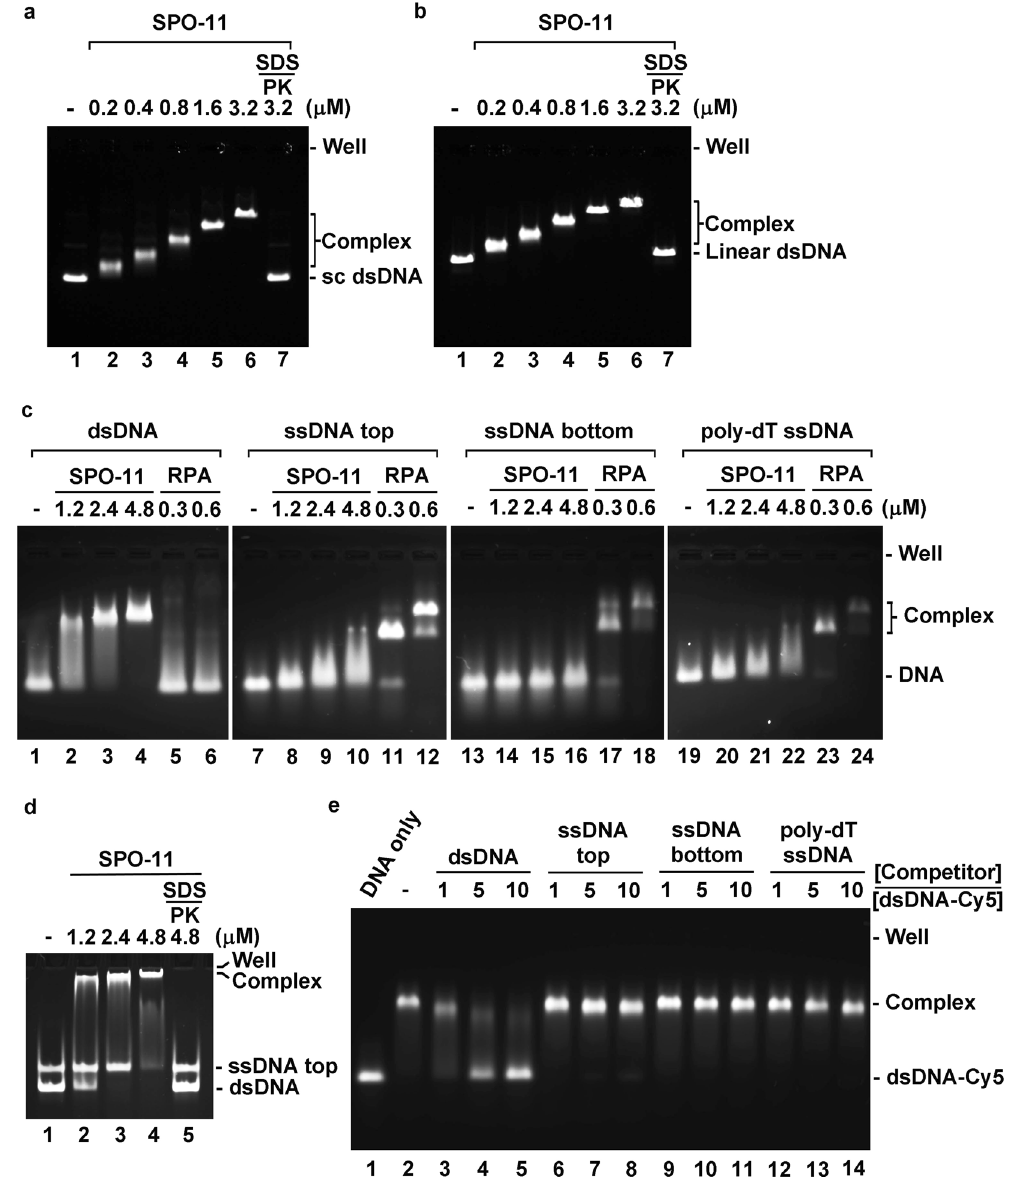
Figure 4. Preferential binding of dsDNA by SPO-11. Negatively supercoiled dsDNA (sc dsDNA) ( a ) or linear dsDNA ( b ) was used as substrate for SPO-11. ( c ) Binding of the 80 bp dsDNA, its constituent top and bottom ssDNA strands, and 80-mer poly-dT by SPO-11 was tested. The ssDNA binding protein RPA was included in the analysis. ( d ) The 80 bp dsDNA and top ssDNA strand were co-incubated with the indicated concentration of SPO-11. ( e ) Complex of SPO-11 and Cy5-labeled dsDNA was challenged with a 1, 5, or 10-fold molar amount of the indicated unlabeled DNA. Note that the agarose gels in panels a and b were stained with ethidium bromide; gels in panels c and d were stained with SYBR Gold to allow better detection of the ssDNA; DNA in the gel in panel e was detected by Cy5 fluorescence. In panels a, b, and d, PK denotes proteinase